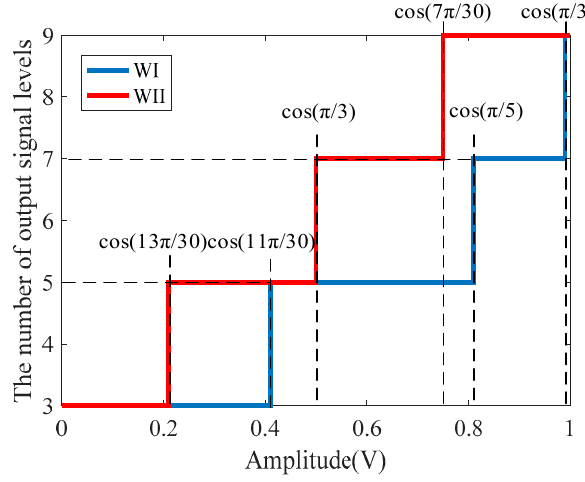
Figure 4. Diagram of the relationship between the number of levels and a ( t ).